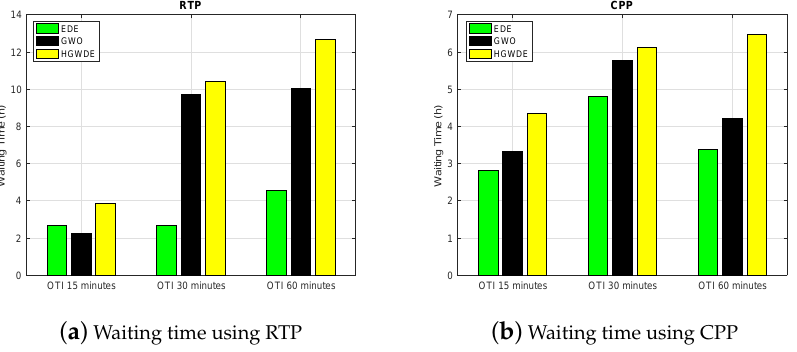
Figure 9. Average waiting time of appliances using RTP and CPP.